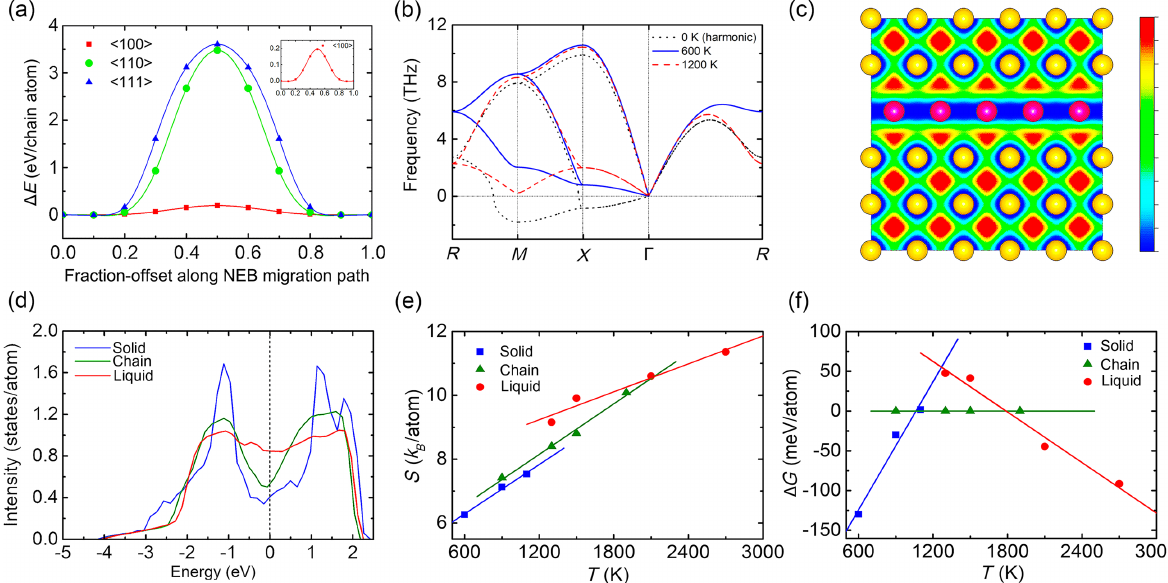
FIG. 5. Intrinsic properties associated with chain-melting regime from DFT calculations. (a) Migration energy barriers along the edge h 100 i , face diagonal h 110 i , body diagonal h 111 i in sc Ca calculated using nudged-elastic-band (NEB) methods. (b) Harmonic phonon spectra and renormalized anharmonic phonon spectra at 600 and 1200 K of sc Ca at 50 GPa. The resoftening of phonon modes near chain melting 1200 K can be found. (c) ELF plot for the transition state of cooperative h 100 i migration in a sc Ca supercell; ELF values are shown from 0 (blue) to 1 (red). Yellow and magenta circles correspond to atoms with solidlike and diffusive atoms. (d) Averaged electronic DOS for solid (blue solid line), chain melting (green solid line), liquid (red solid line) of sc Ca at 50 GPa with the Fermi energy (black dot line). Note the pseudogap, providing an electronic stabilization to sc Ca, which persists even in the chain melt, and eventually disappears in the liquid. (e),(f) Entropy S and relative Gibbs free energy Δ G of the Ca system from 600 to 2700 K at 50 GPa. Free-energy values of the chain-melting states are used as the baseline. Square (blue), triangle (green), and circle (red) represent solid, chain melting, and liquid, respectively, and solid lines are drawn as guides to the eye.